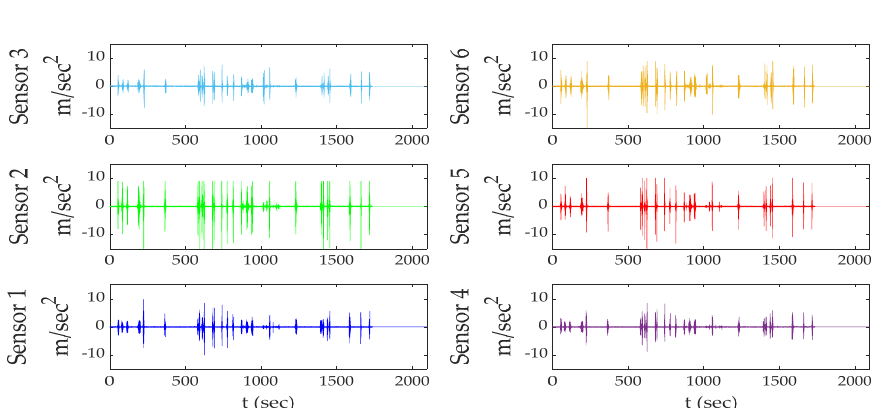
Figure 9. Recorded acceleration of total time histories in the vertical direction (axis Z) per